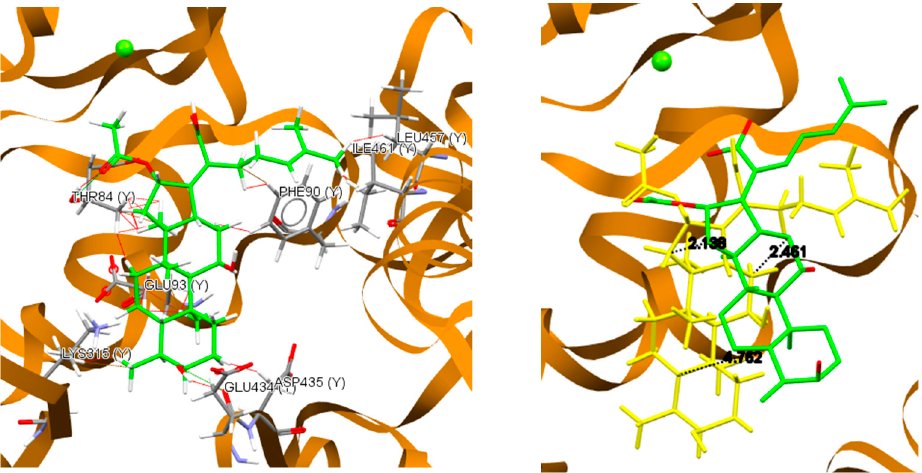
Figure 5. Comparison of X-ray diffraction data (green color) and the result of molecular docking of fusidic acid (yellow color).